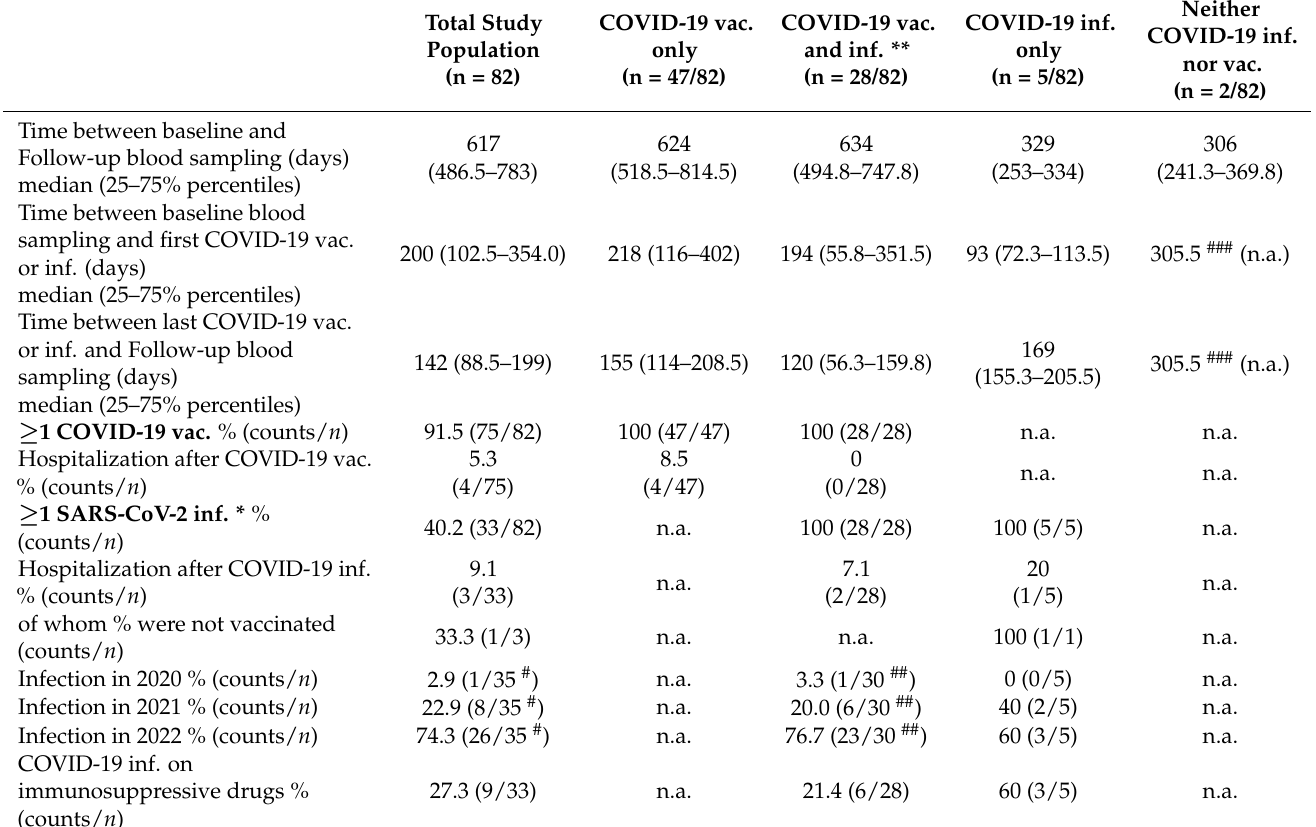
Table 3. The patients’ characteristics after COVID-19 vaccination and/or infection (follow-up). Total Study COVID-19 Population (n = 82)